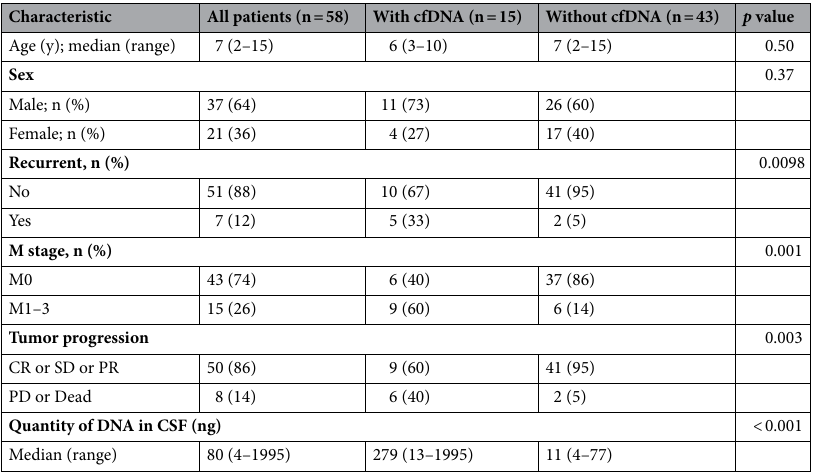
Table 2. Associations between clinical characteristics and